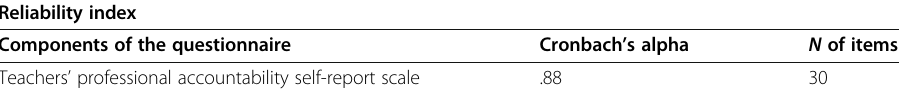
Table 1 Cronbach ’ s alpha of the teachers professional accountability questionnaire Reliability